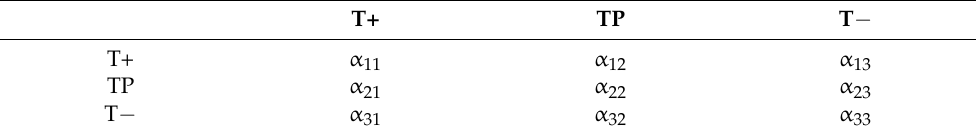
Table A1. Example of competition